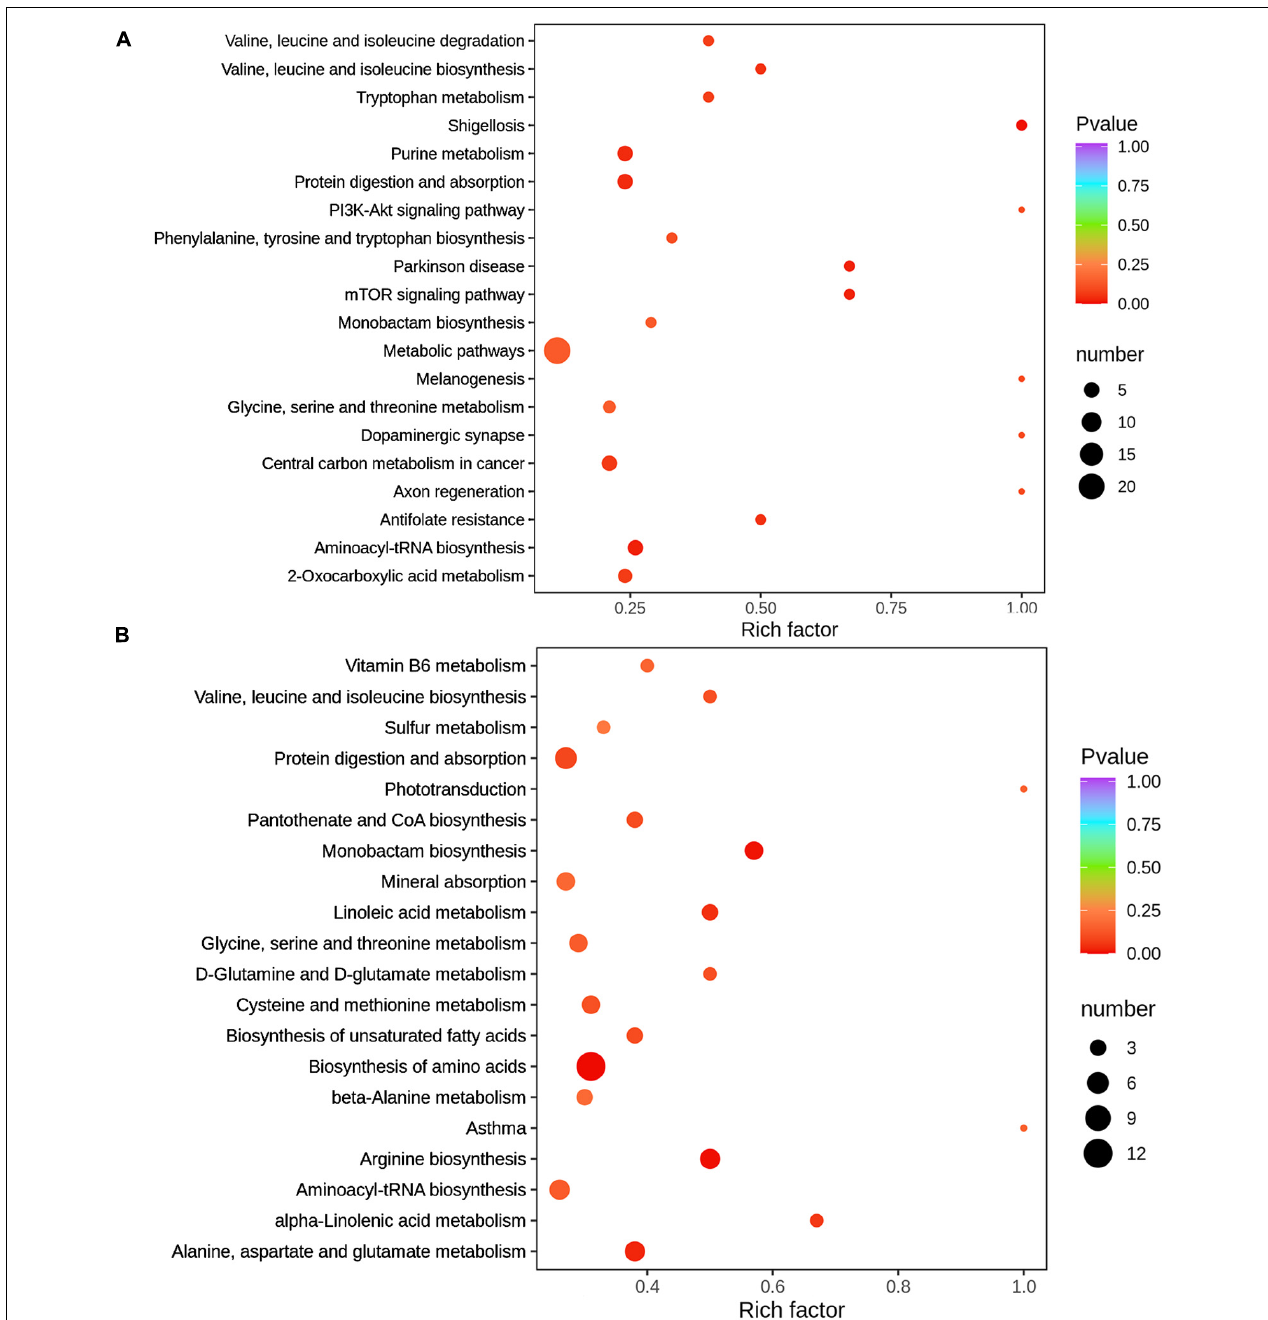
FIGURE 7 | Milk metabolomic pathways analysis of sows fed with the MBP diet. (A) Top 20 of pathway enrichment in the colostrum of sows treated with MBP diet. (B) Top 20 of pathway enrichment in the transitional milk of sows treated with MBP diet. The x axis indicates the rich factor corresponding to each pathway, and the y axis indicates name of the KEGG metabolic pathways. The size and color of bubbles represent the number and degree of enrichment of different metabolites,